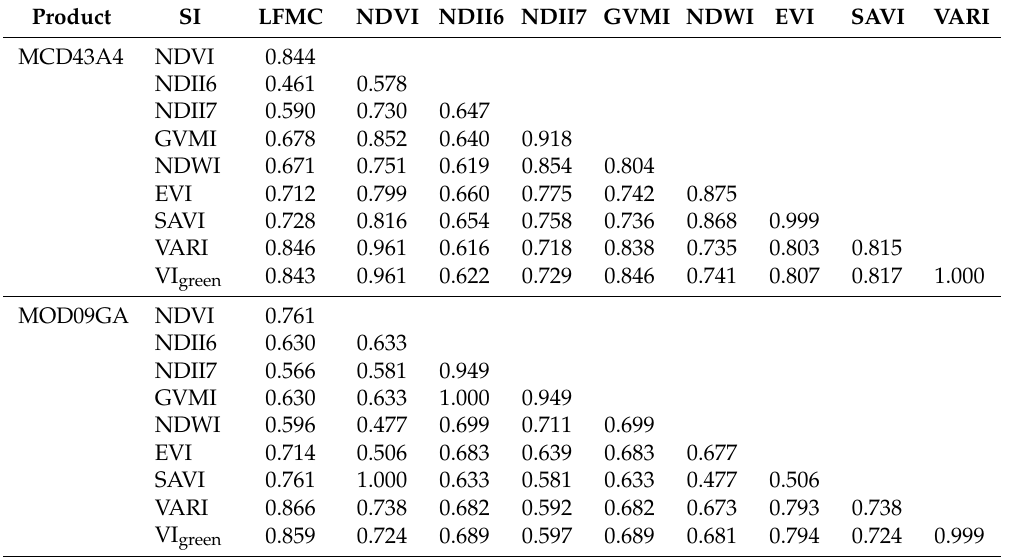
Table 3. Pearson correlation matrix for each MODIS product calibration dataset. All correlations significant at p -value < 0.001.